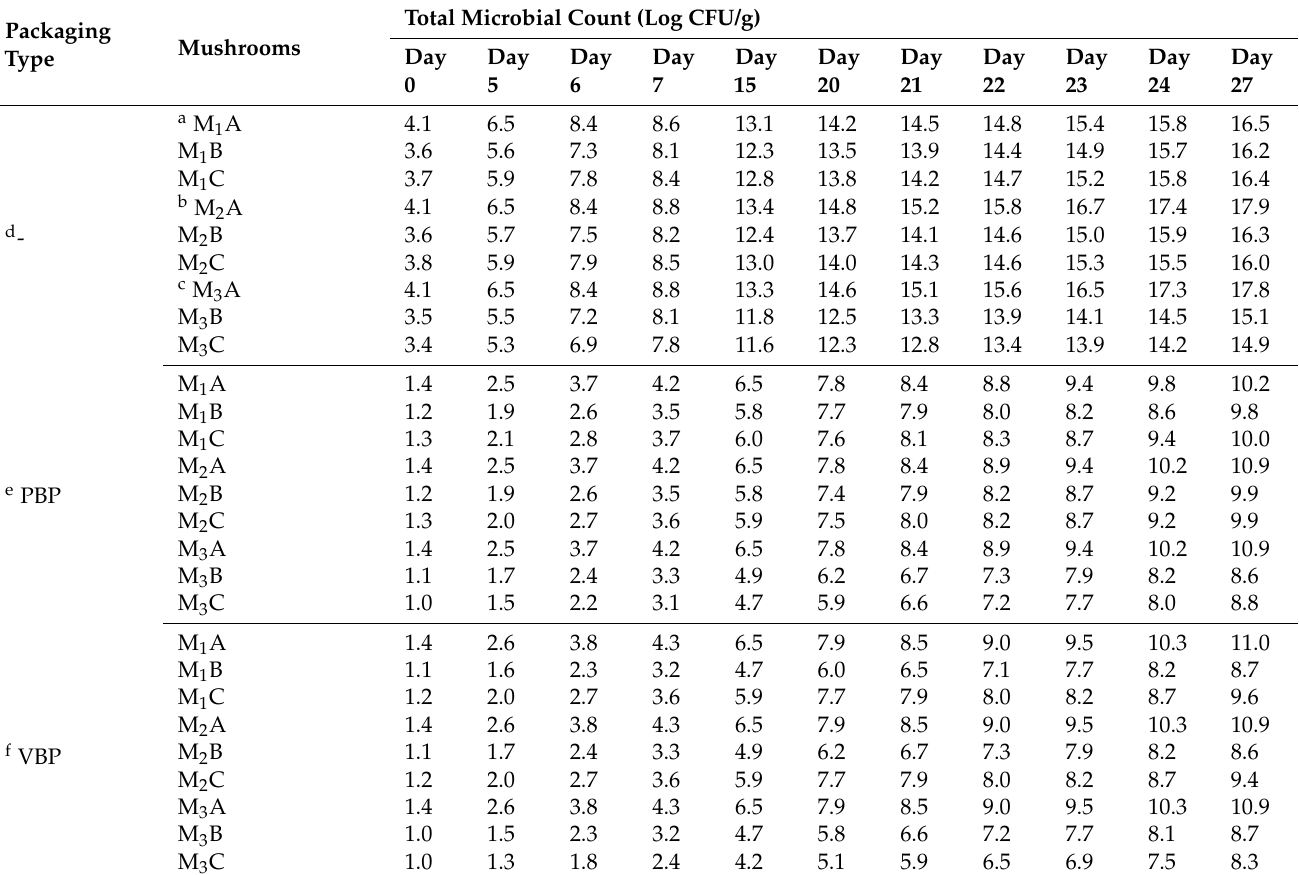
Table 9. Total microbial count on mushrooms stored at 4 ◦ C (log